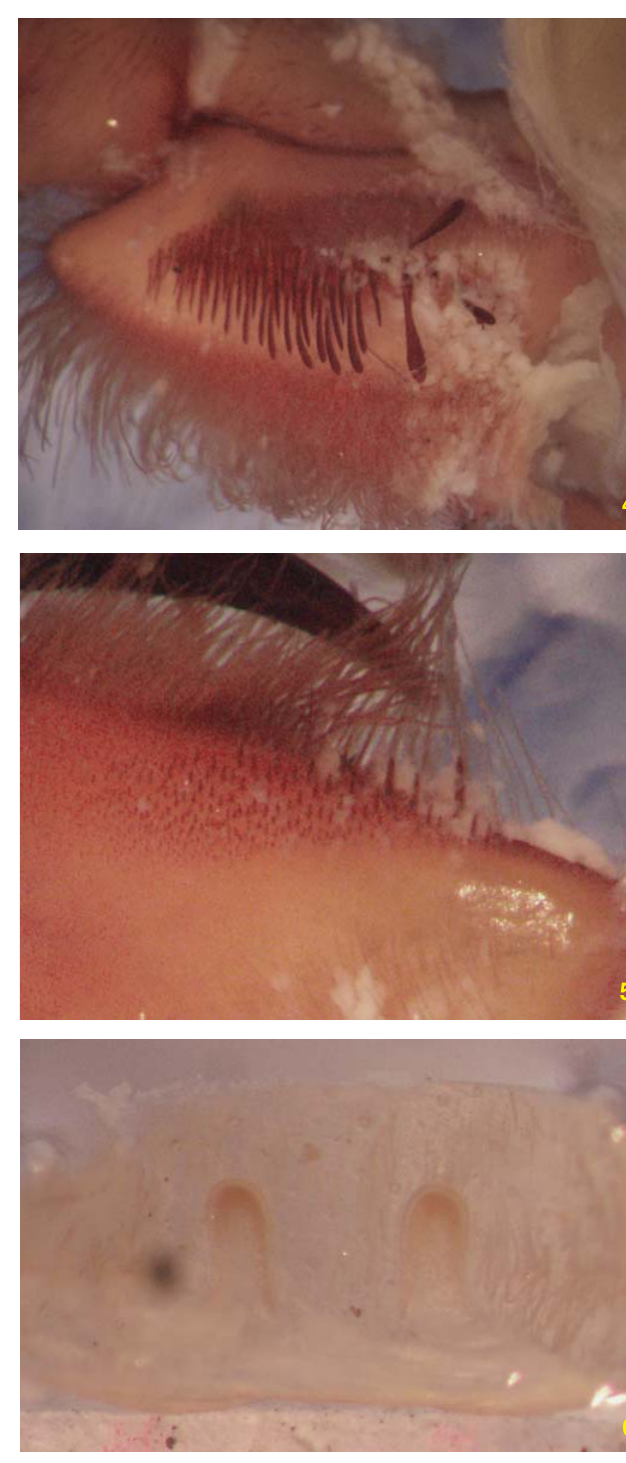
Images 4-6. Chilobrachys khasiensis (Tikader, 1977) (originally described as Ischnocolus khasiensis Tikader, 1977), female. 4 - maxilla, retrolateral view, showing stridulatory